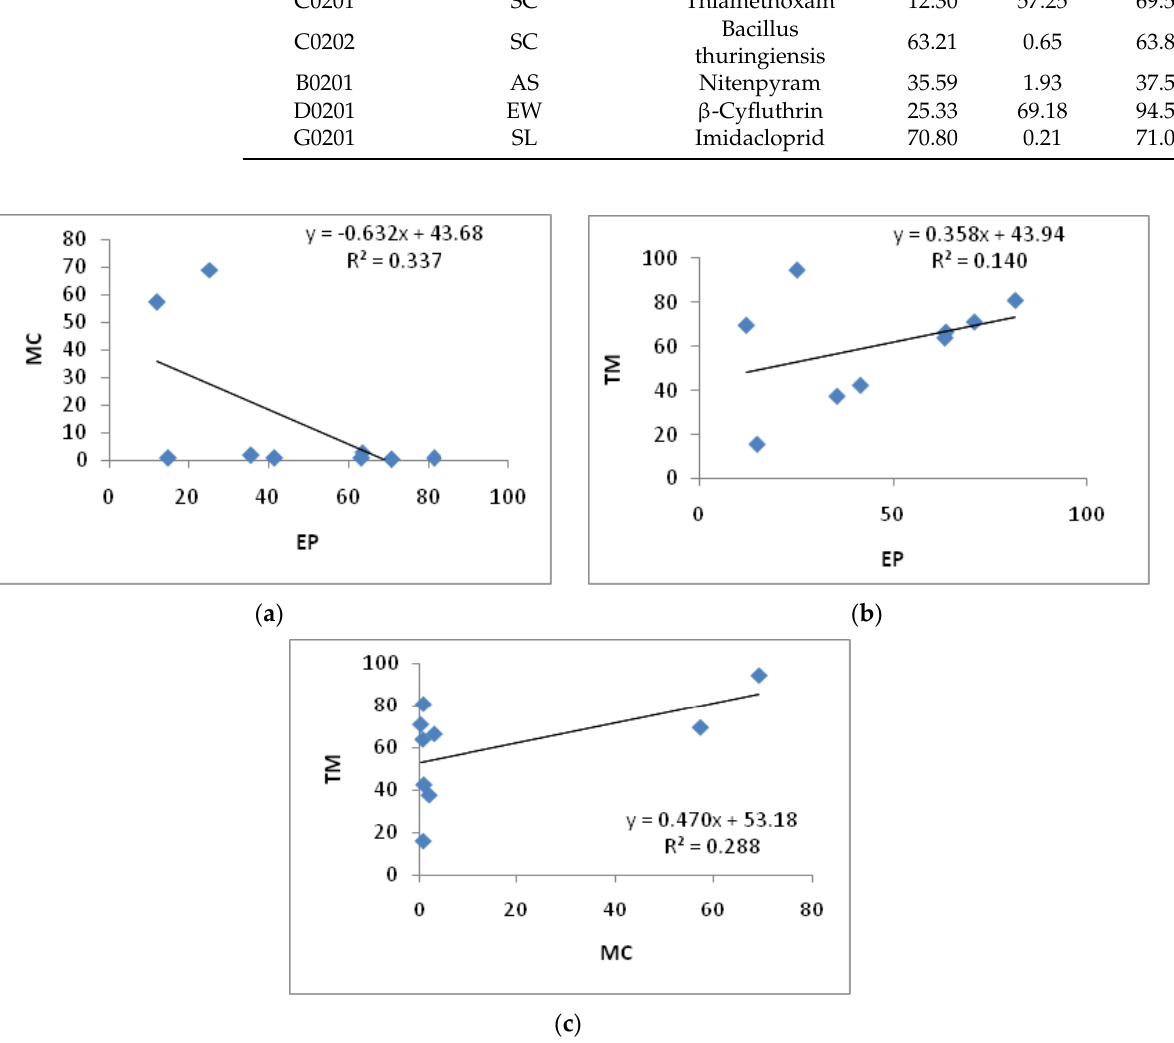
Figure 4. (a): Correlation analysis between MC and EP of insecticide products. (b): Correlation Figure 4. ( a ): Correlation analysis between MC and EP of insecticide products. ( b ): Correlation analysis between TM and EP of insecticide products. (c): Correlation analysis between TM and MC analysis between TM and EP of insecticide products. ( c ): Correlation analysis between TM and MC of insecticide products. of insecticide